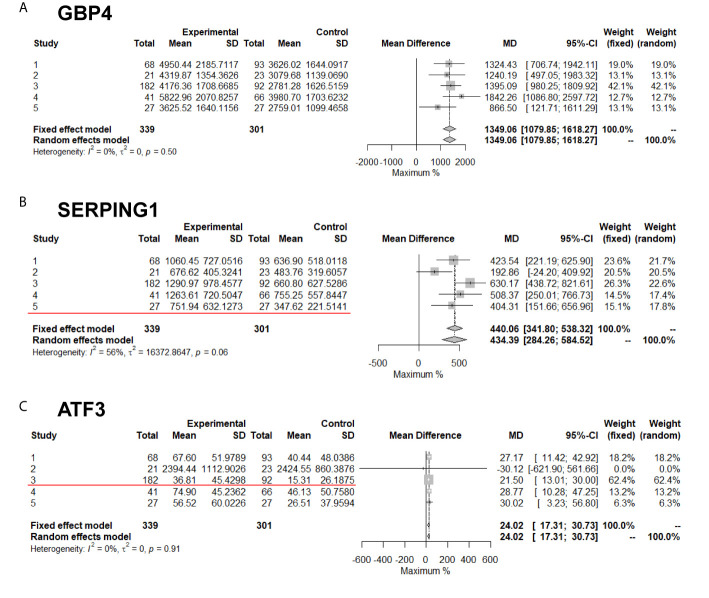
Meta-analysis of DEGs with or without twofold change among five studies. The Red line marked results are two-fold change. (A) GBP4; (B) SERPING1; (C) ATF3 genes' expression in meta-analysis.